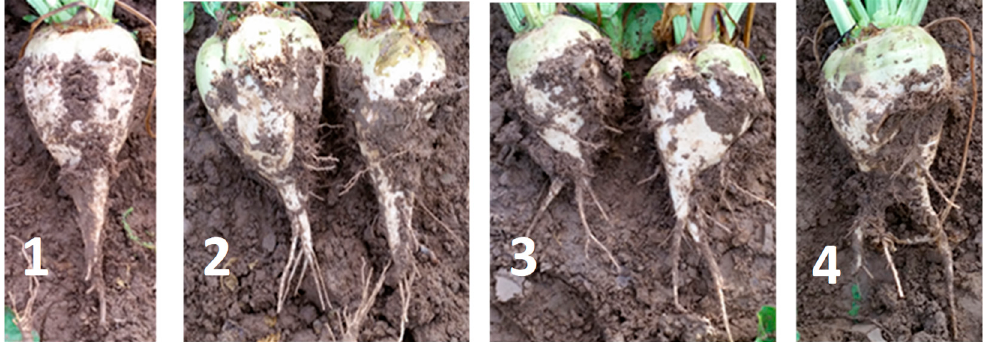
Figure 4. Four root deformation classes from not to seriously deformed (( 1 – 4 ), respectively). Classes 3 and 4 are here defined as seriously deformed.